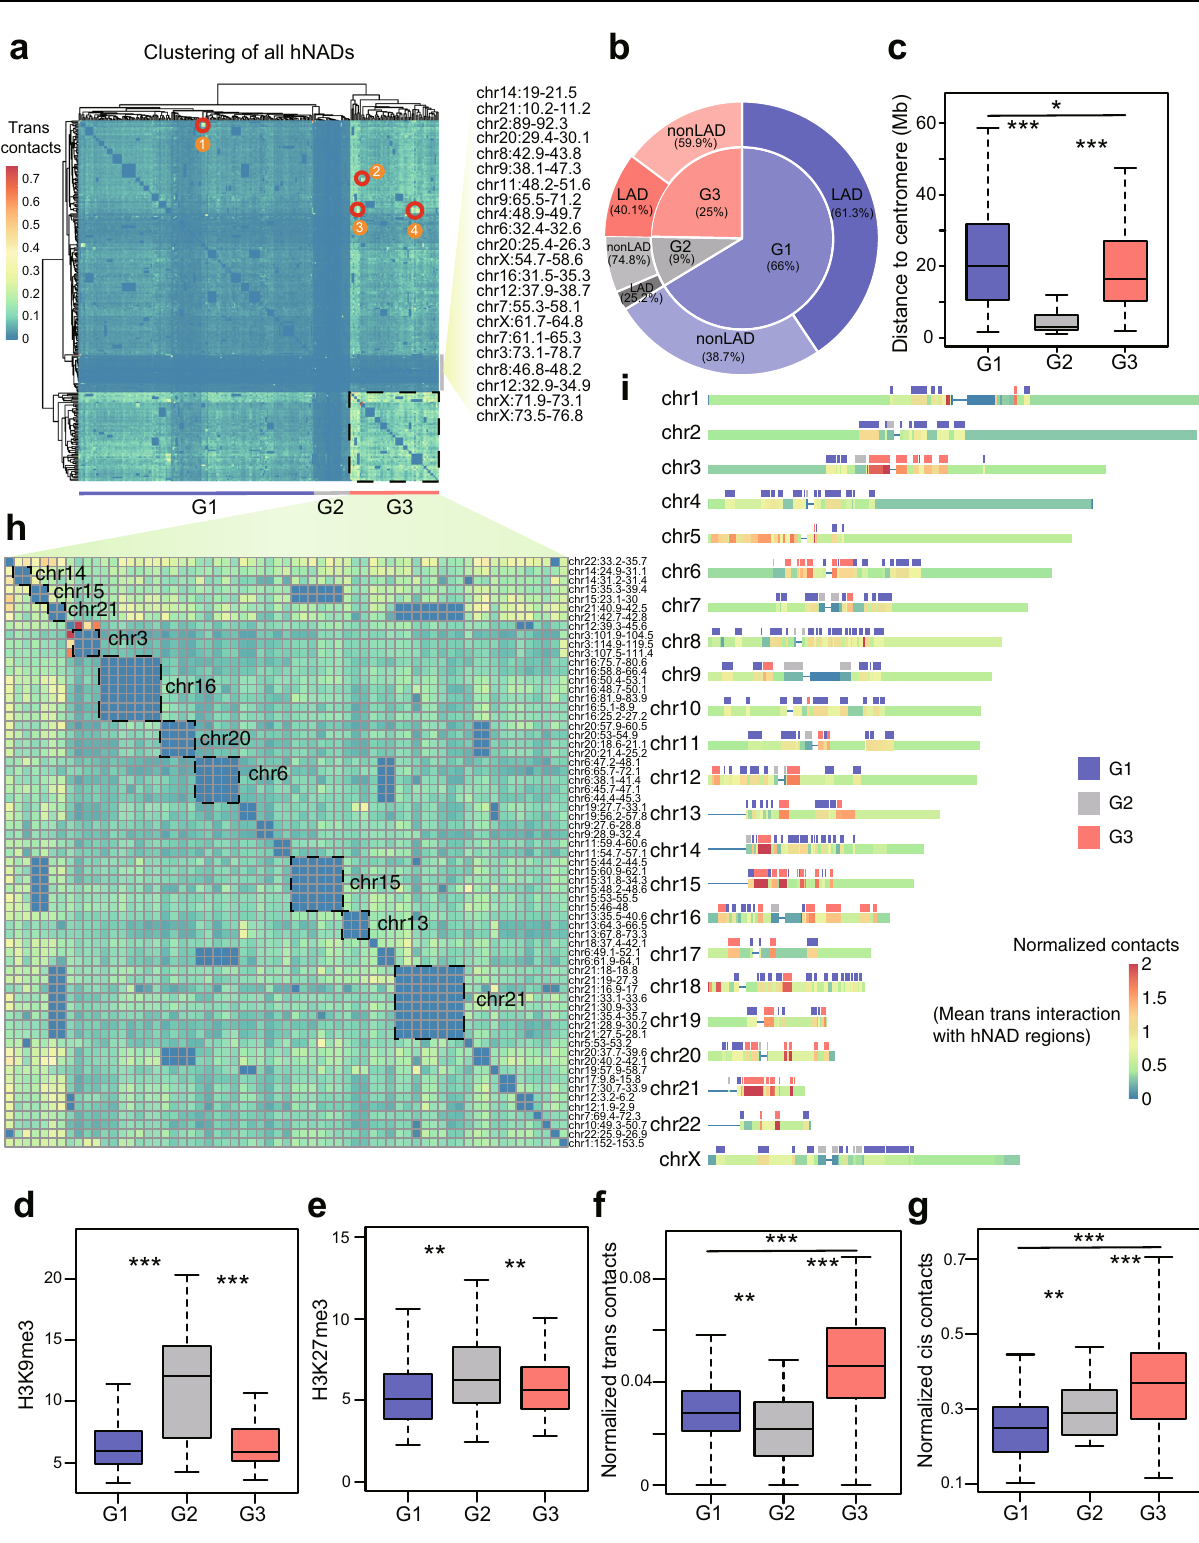
hNADs. i Mean trans interaction level of chromosomal bins with other hNADs and the locations of G1, G2,and G3 hNADs. In all box-plots ( c – g ),center line stands for median;boxlimitsare the25thand75thpercentiles. n =177(G1), n =22(G2), n =65 (G3).Statisticallysigni fi cantdifferencesareindicatedandwerecalculatedwithtwo- sidedWilcoxontest.* p <0.05,** p <0.01,*** p <0.001.Sourcedataareprovidedasa Source Data fi